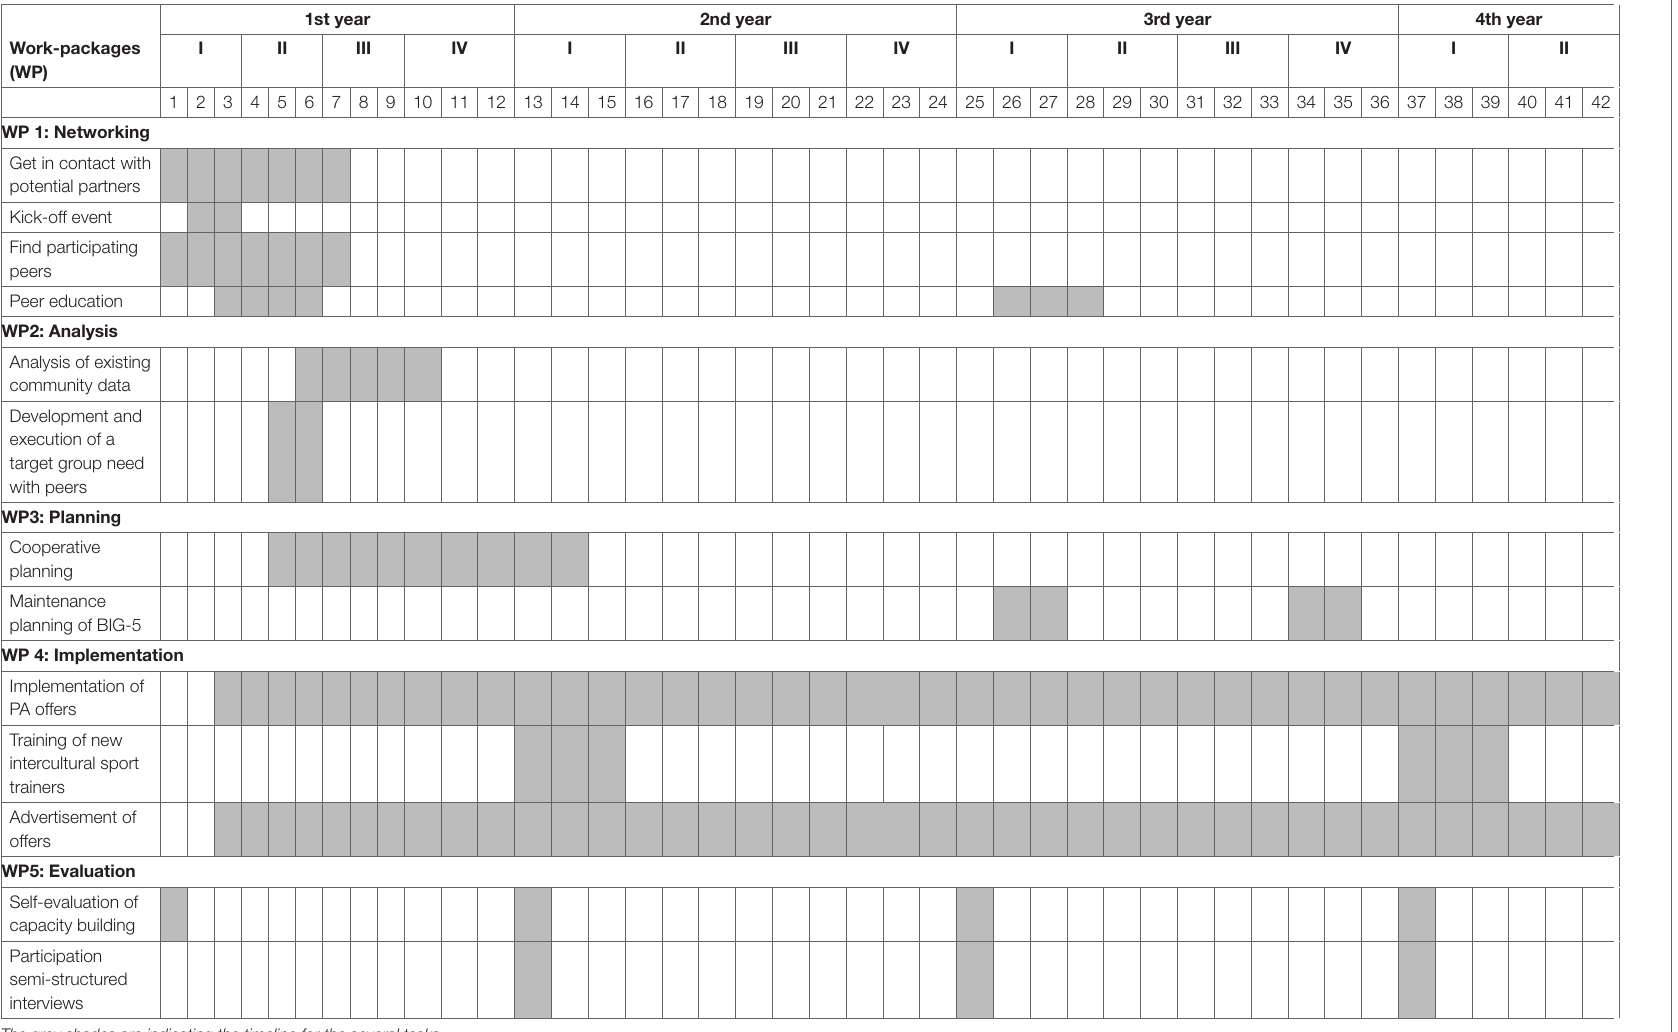
The grey shades are indicating the timeline for the several